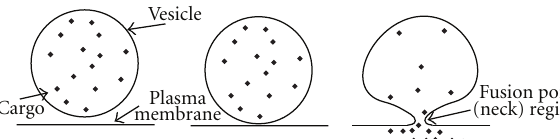
Figure 1: Schematic illustration of the vesicle fusion with the plasma membrane. Note that the fusion pore is a narrow membra- nous neck connecting the vesicle to the plasma membrane.